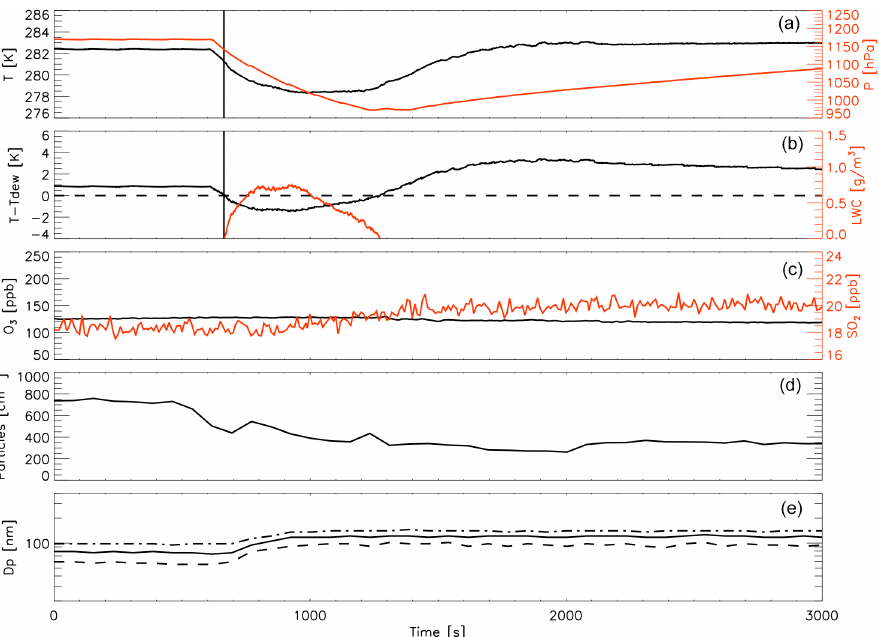
Figure 5. Measured parameters during the second expansion performed on 17 November 2013. (a) the time series of pressure and temper- ature, with the expansion occurring at approximately 600s. The resulting temperature decrease below the dew point and increase in liquid water content are shown in (b) . Vertical lines in (a) and (b) indicate the time at which the SIMONE first detected enhanced forward scatter- ing, indicating the presence of droplets. The temperature measured at this time was taken as the dew point and thus the total water content could be calculated. (c) and (d) show gas mixing ratios and the total density of particles, while (e) shows the diameter of the 25th and 75th percentile of particles, as well as the median diameter (dashed, dot-dashed and solid lines